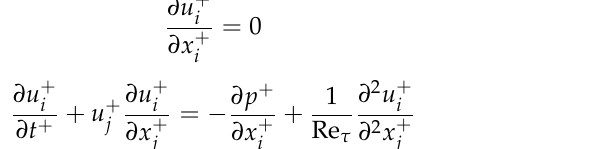
Table 2. Information related to the computational domain, number of grids, and resolution with different ratios between the g (gap) and w (width) of the superhydrophobic surface.